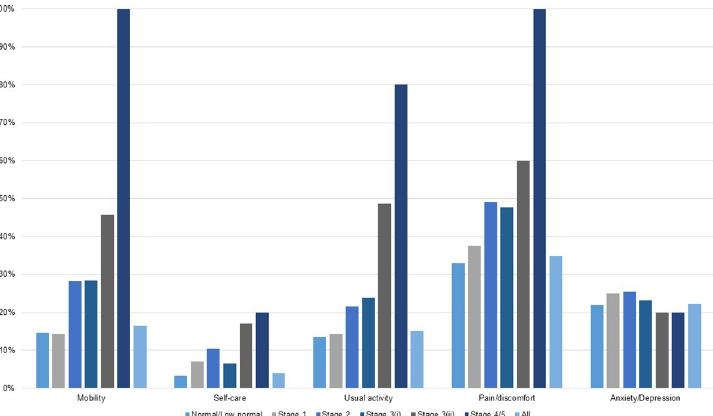
Fig 1. The proportion of respondents reporting any problems in each domain of EQ-5D questionnaire. Note: Stage 3(i): Stage 3 CKD with albuminuria, Stage 3(ii): Stage 3 CKD without albuminuria.